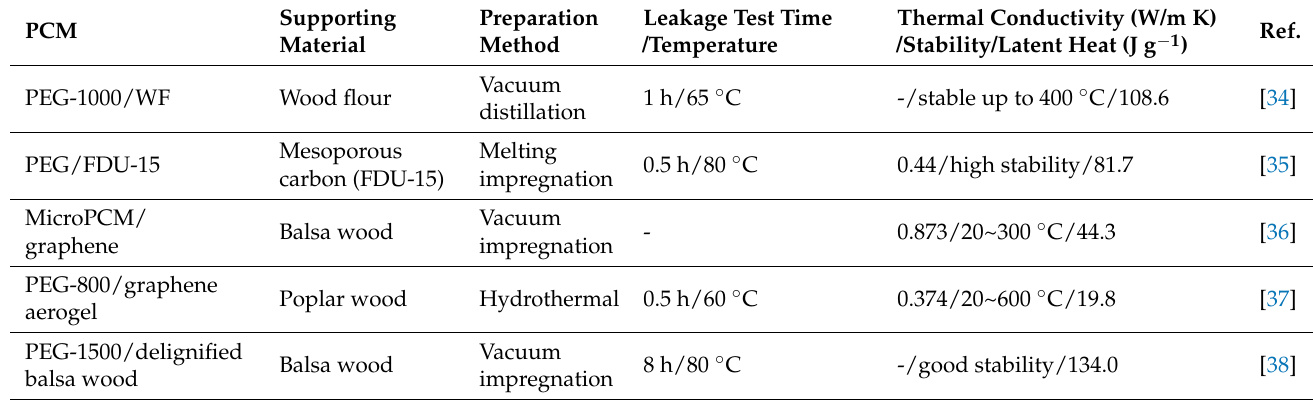
Figure 4. ( a ) Leakage profile data (PEG mass fraction as a function of time) of the balsa wood-based form-stable composite PCMs; ( b ) ratios of experimental phase change enthalpies w.r.t the theoretical phase change enthalpies for various PEG masses loaded in form-stable composite PCMs and ( c ) seepage tests images for pure PEG and wood-derived composite PCMs under external force and longitudinal vascular directions W-L+P and W-L, H+P. Adopted with permission from the reference [38], copyright 2020, Elsevier B.V. Table 1. Physicochemical parameters of selected PCM materials mentioned in this section.